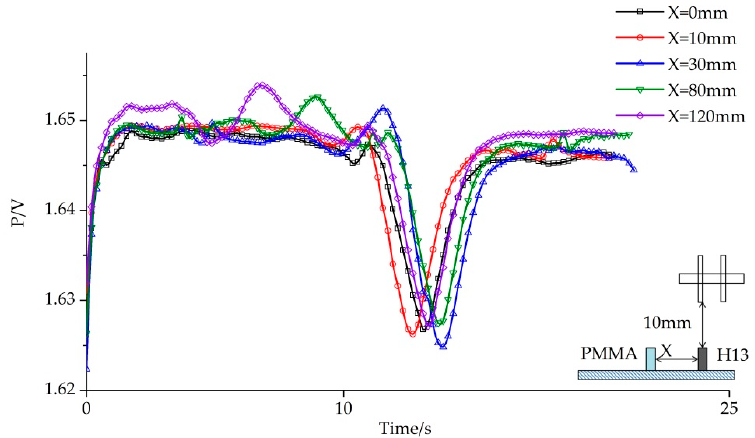
Figure 7. The electric signal image identifying PMMA and H13 under different values of “X”.